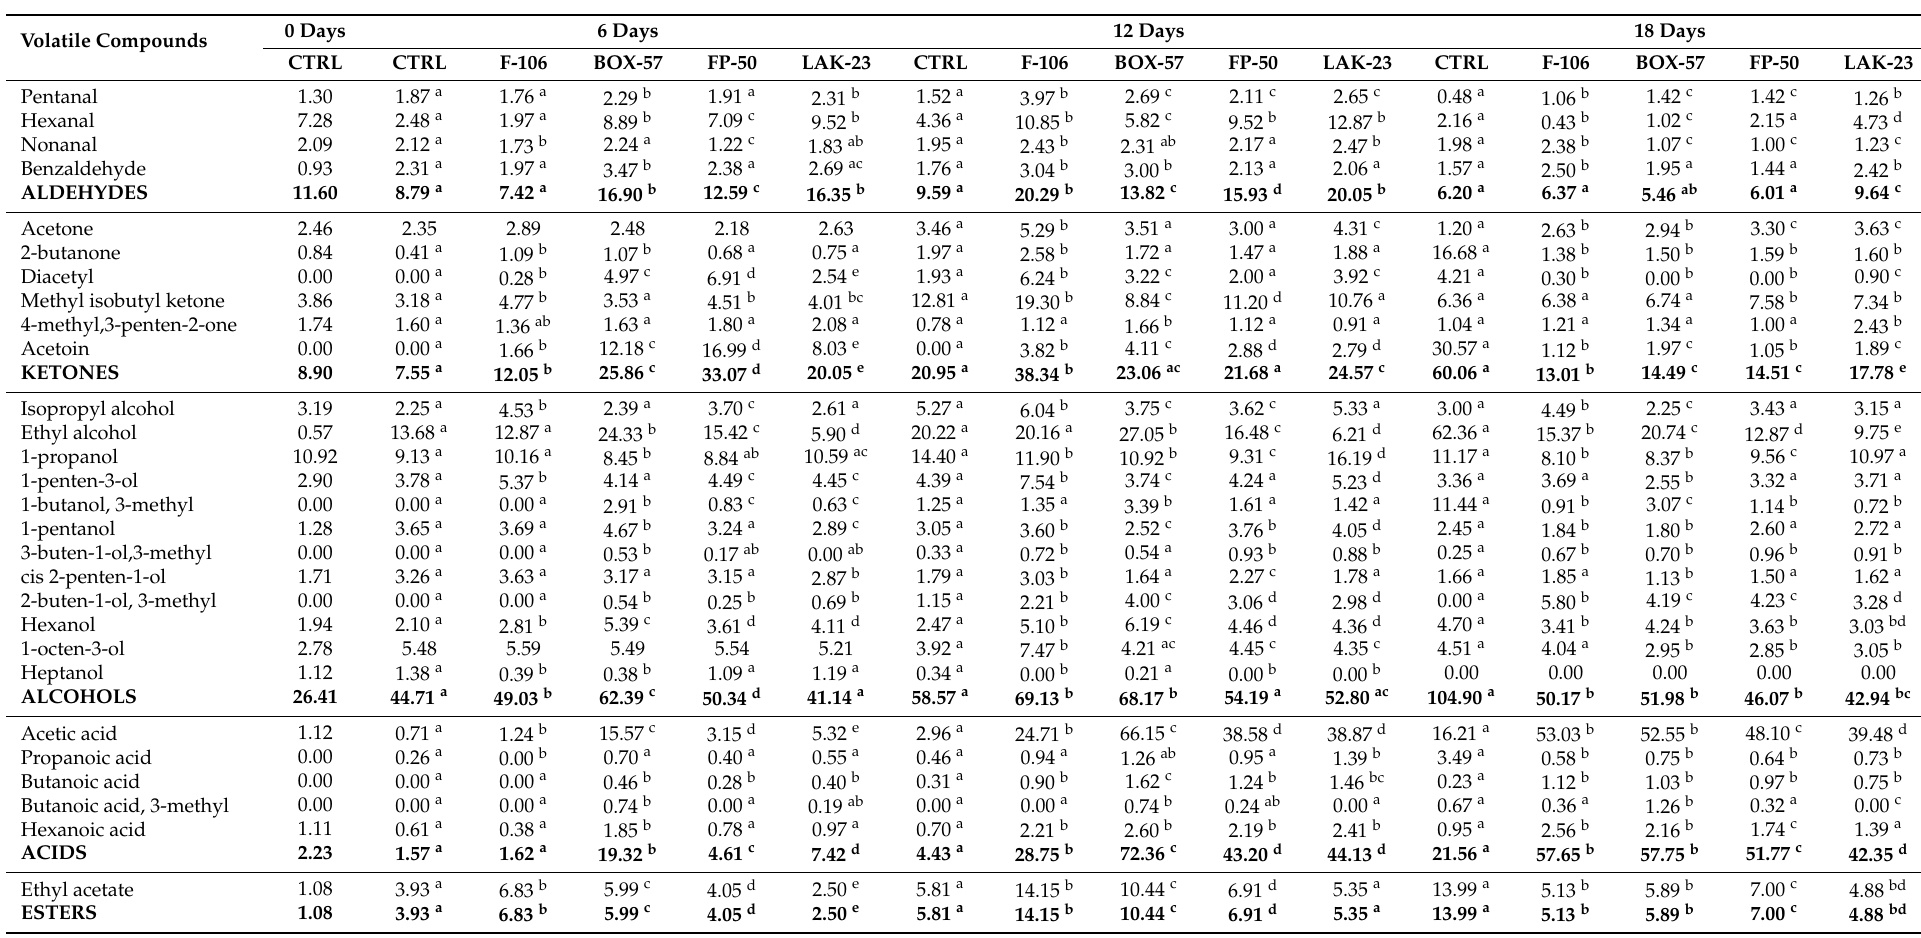
Table 2. Mean values of volatile compounds identified at 0, 6, 12, and 18 days of storage in the different burgers. CRTL, control non inoculated; Starter added: F-106, Lacticaseibacillus casei ; BOX-57, Carnobacterium divergens, C. maltoaromaticum, and L. sakei bacteriocin producer; FP-50, Carnobacterium divergens, C. maltoaromaticum; LAK-23, Lactobacillus sakei bacteriocin producer. Data are the mean of three replicates and are expressed as a ratio between peak area of each molecule and peak area of the internal standard (4-methyl-2-pentanol). For each molecule, significant differences according to ANOVA between samples, collected at each storage time, are indicated by the presence of different